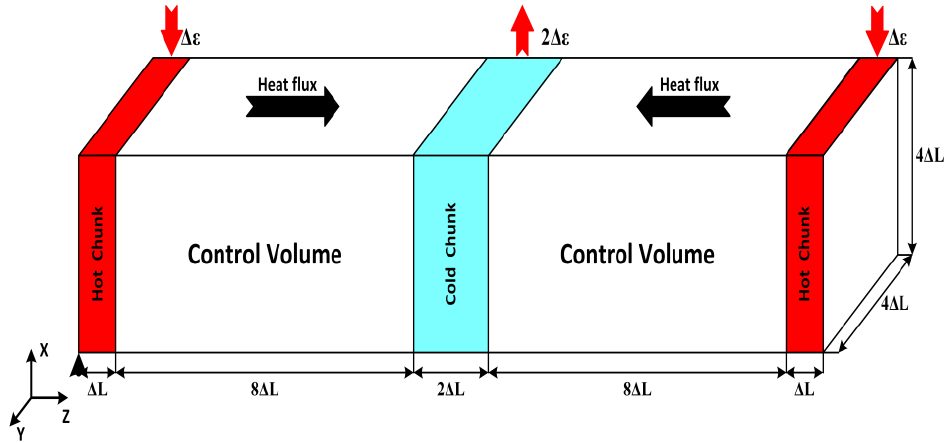
Figure 1. The simulation model for calculating the thermal conductivity of n-alcohols. Seven kinds of n-alcohols with straight chain (i.e., C 2 H 5 OH, C 3 H 7 OH, C 4 H 9 OH, C 5 H 11 OH, C 6 H 13 OH, C 7 H 15 OH and C 8 H 17 OH) are selected in this paper to investigate the effect of a carbon chain on the heat transfer mechanisms. The OPLS-AA (Optimized Potentials for Liquid Simulations All-Atom) field [25,26] was applied to calculate the interactions for alcohols. The corresponding OPLS-AA calculating parameters of alcohols are generated from the LigParGen web server [27], as listed in Tables 1–4. The crossed Lennard-Jones parameters for a heterogeneous pair are obtained by the famous Lorentz- Berthelot mixed rule [28], that is, ε ij = ( ε i · ε j ) 1/2 and σ ij = ( σ i + σ j